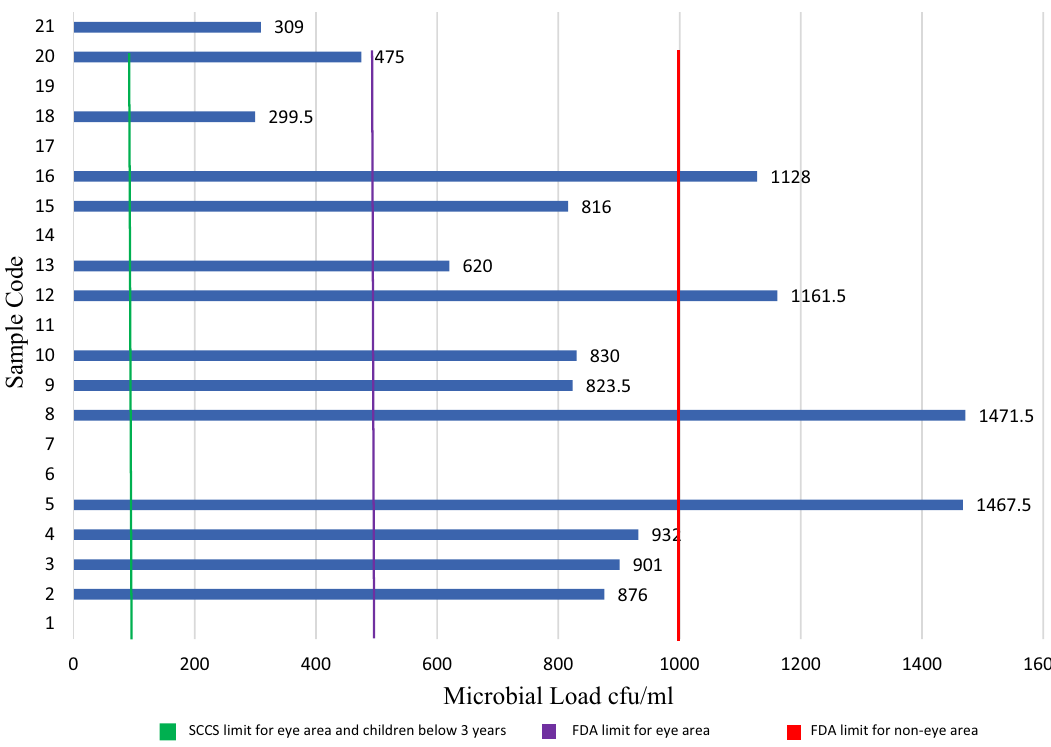
Figure 3. Microbial count results and permitted limits according to the FDA 14 and SCCS 16